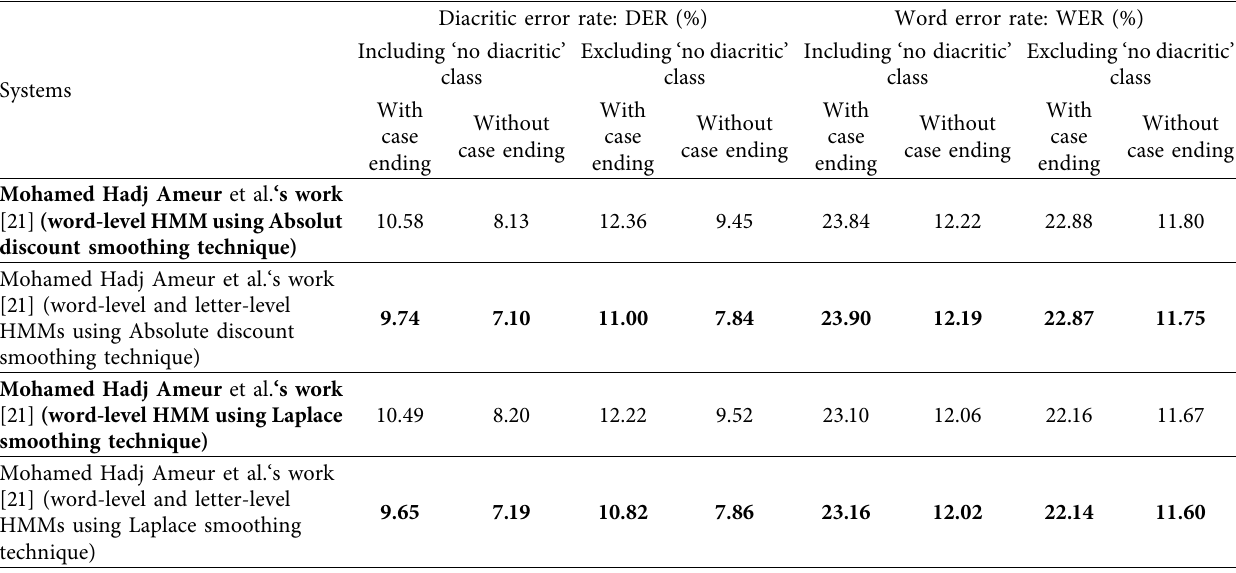
Table 4: Error rates of the HMM-based systems